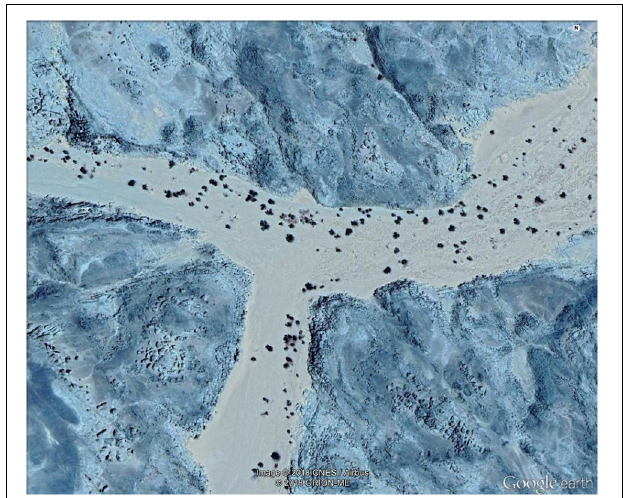
FIGURE 10 | Google Earth view of a proposed new population of M . argun in the northwestern part of the Sahara within Sudan (the geographic coordinates: 21 ◦ 57 (cid:48) 37.31 (cid:48)(cid:48) N, 25 ◦ 07 (cid:48) 13.83 (cid:48)(cid:48)